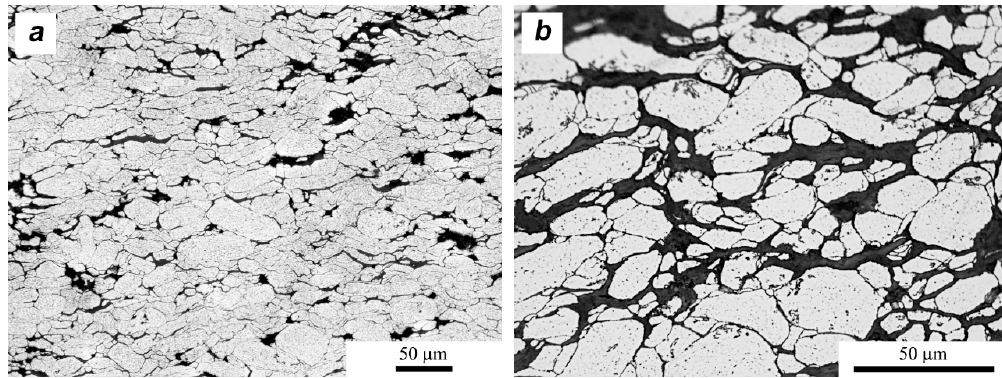
Figure 12. Microstructure of AA6061/MLG 10 vol % (SPS sinter). ( a ) general; (b ) close-up view.